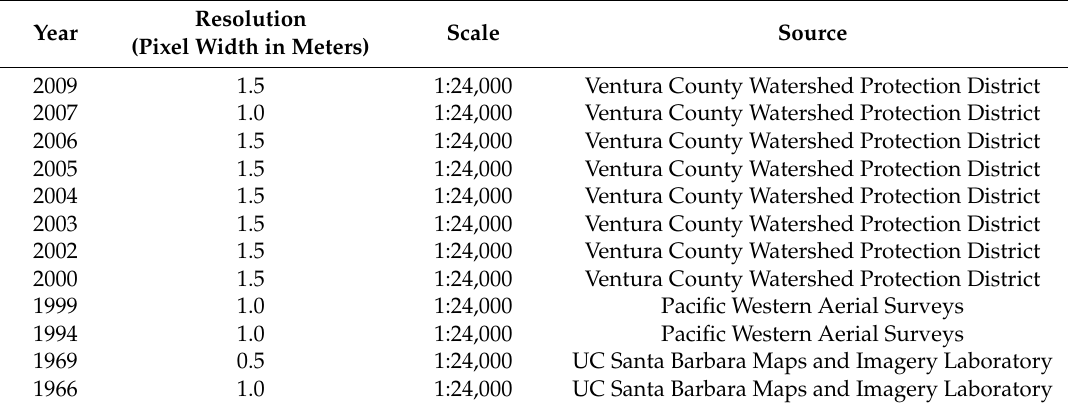
Table 1. Summary of aerial photograph information for site S1. See Figure 1 for location map.